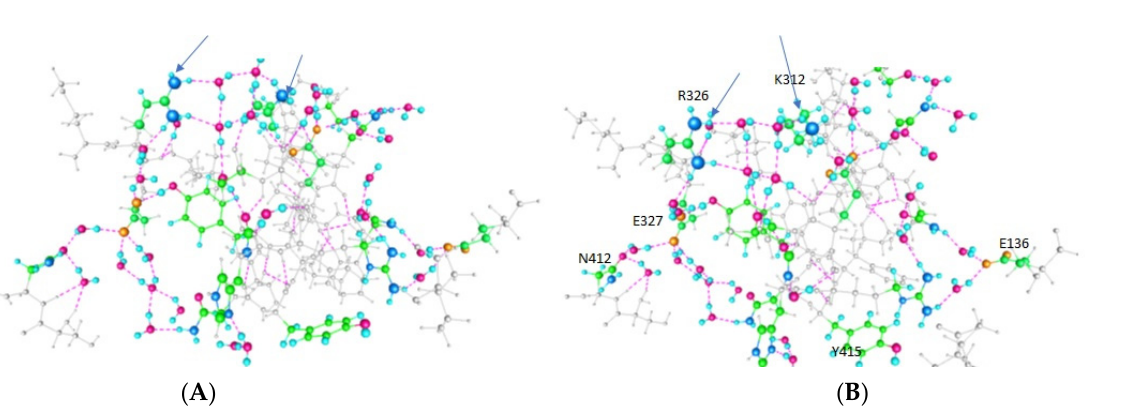
( B ) Figure 3. As in Figure 2, the key residues are labeled in ( B ), and the two paths, plus the crossover, can be seen by following the colored residues. The color code is the same, and the arrows again indicate the position of the two mobile protons (in ( A ) R326 is indicated; that residue is always protonated, but is indicated here as well). Rotation from ( A ) to ( B ) is as in Figure 2. This is one of the two low energy configurations, so this arrangement is considered to be part of the actual pathway.